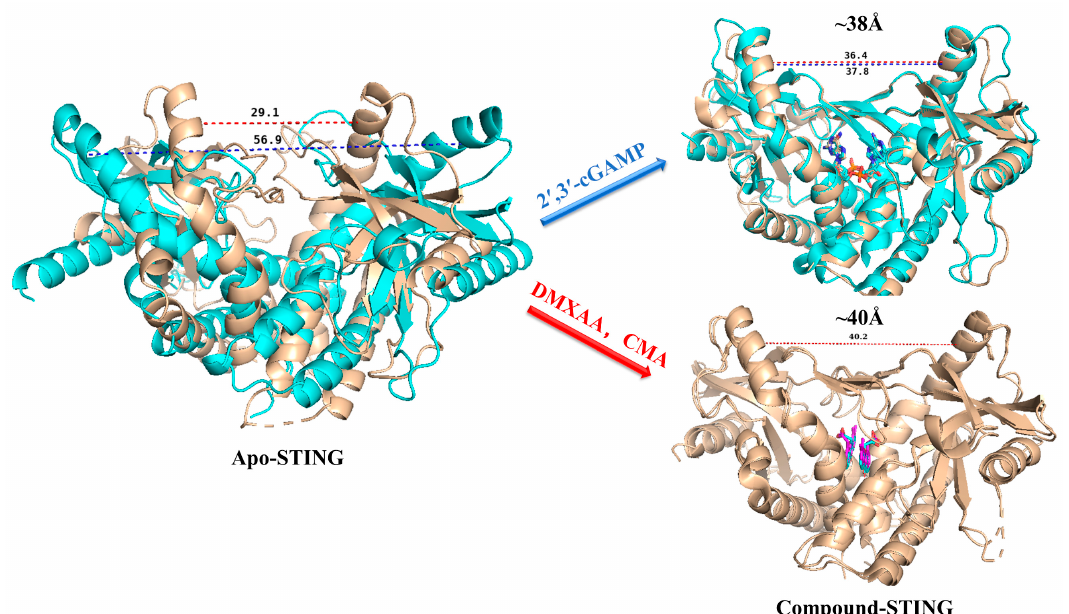
Figure 3. Comparison of apo- and compound-bound STING crystal structures. The mSTING protein is wheat (distance tested with red line), PDB code ： 4KC0 (apo), 4LOJ (bound-cGAMP), 4LOL (bound-DMXAA), and 4JC5 (bound-CMA); the hSTING protein is cyan (distance tested with blue line), PDB code ： 4F5W (apo) and 4LOH (bound-cGAMP).